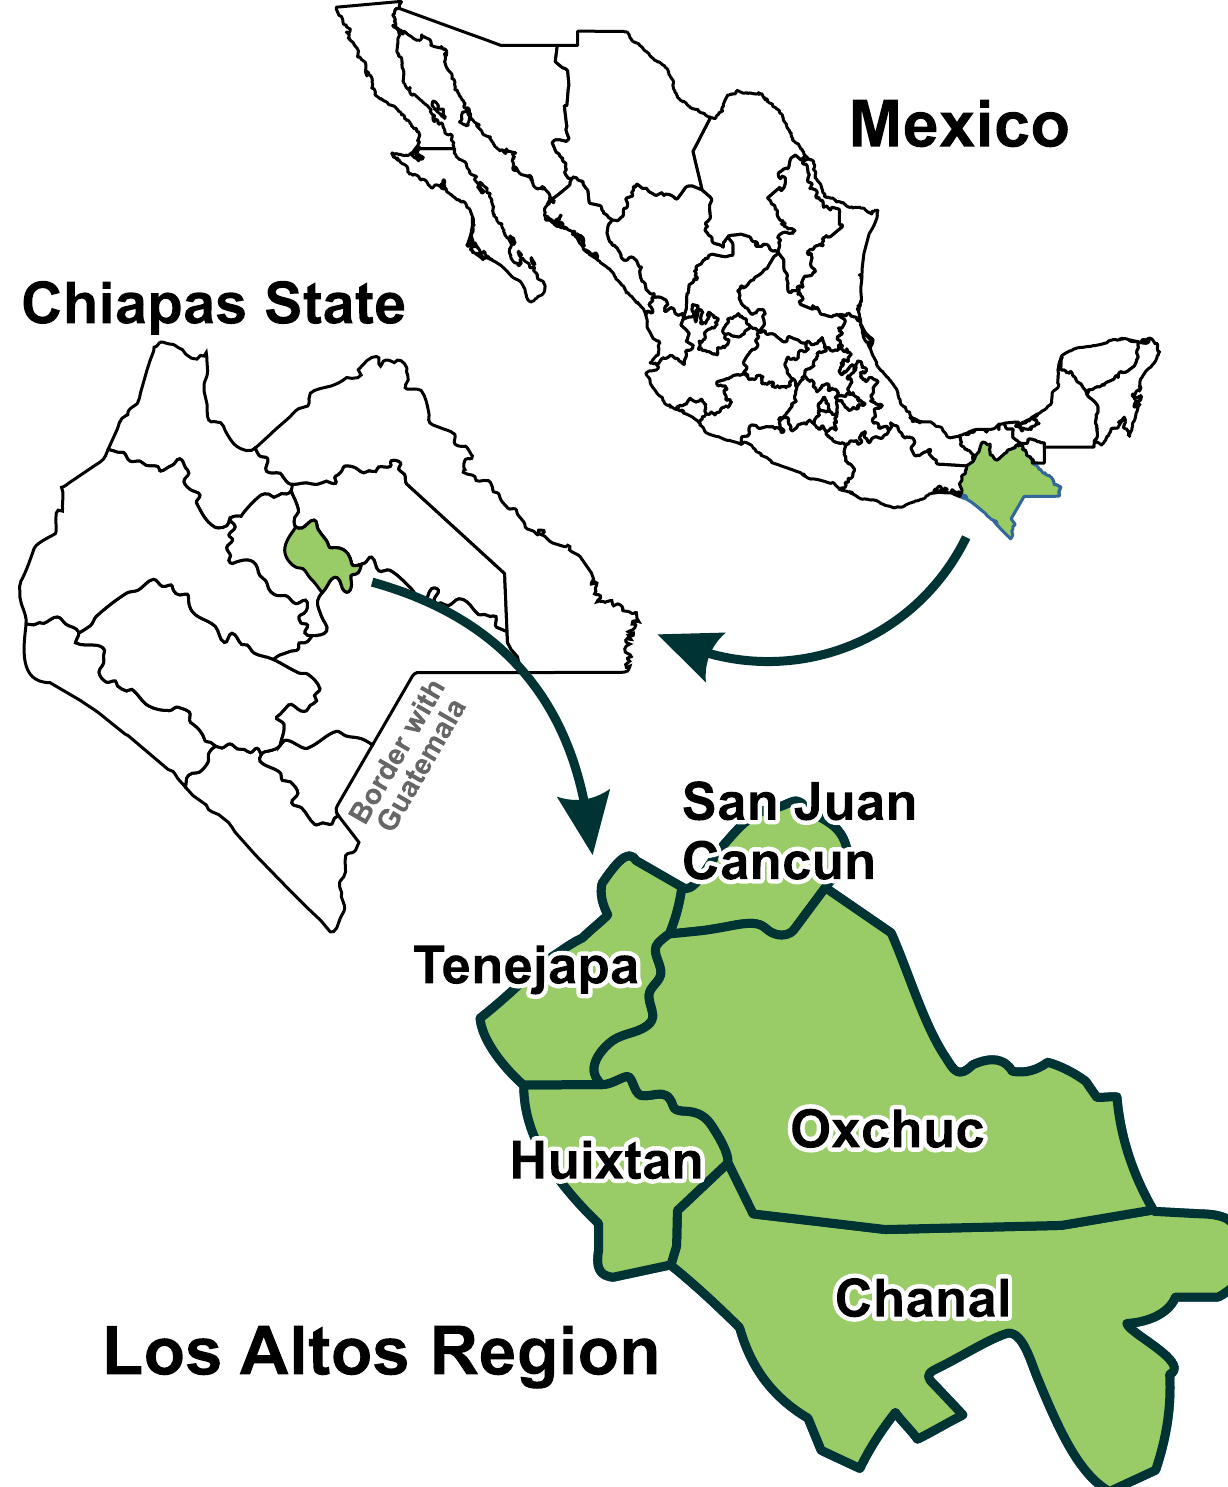
Fig 4. Trachoma endemic municipalities in the state of Chiapas. 2015. Source: Own elaboration based on data from Ochoa H. and collaborators [13].